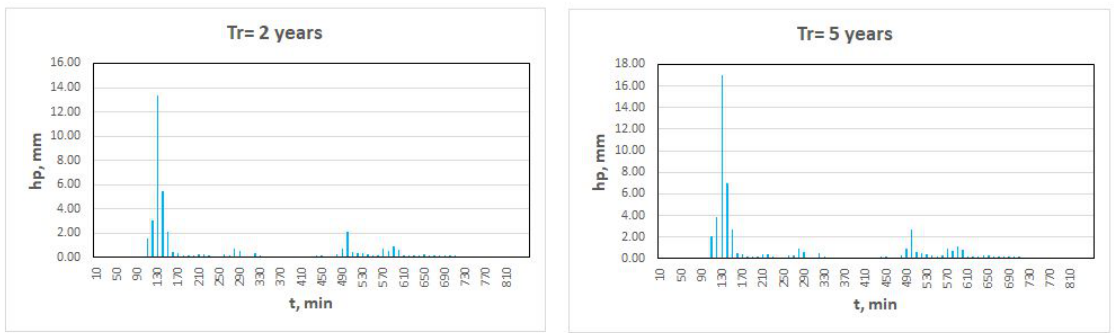
Figure 6. Estimation of the historical annual maximum daily average rainfall for the study site.